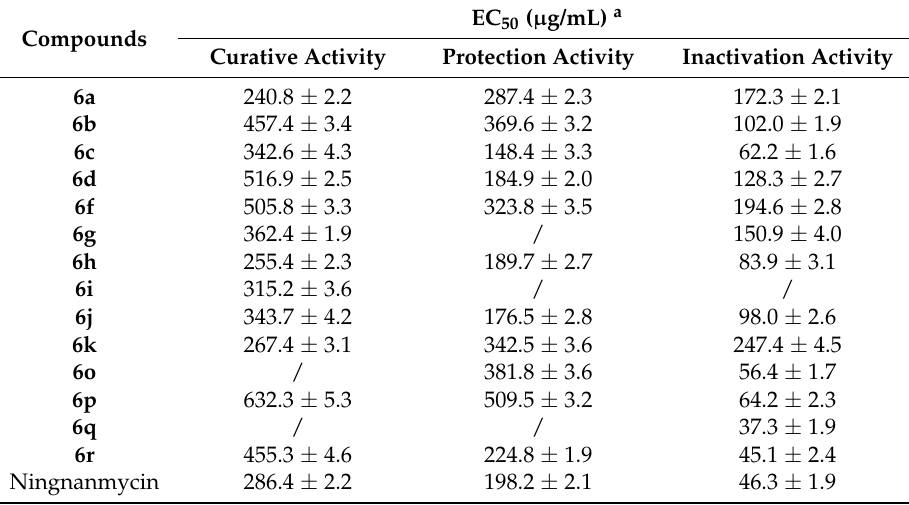
Table 2. The EC 50 values of the testing compounds against TMV in vivo.